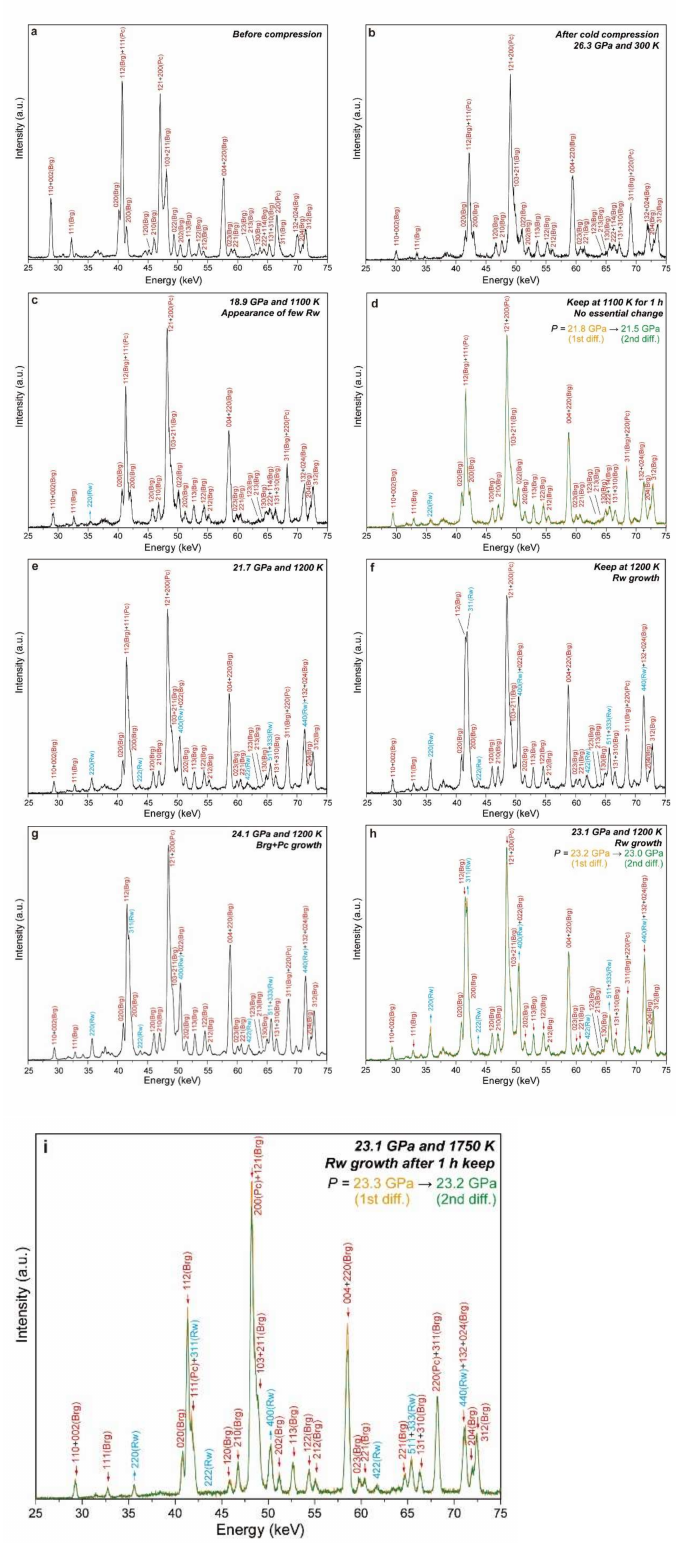
Figure 6. Change in X-ray diffraction patterns of the sample: ( a ) before compression; ( b ) after cold compression; ( c ) after reaching 1100 K; ( d ) maintaining at 1100 K for 1 h; ( e ) after heating to 1200 K; ( f ) after maintaining at 1200 K; ( g ) after increasing pressure to 24.1 GPa at 1200 K; ( h ) during spontaneous pressure decrease from 23.2 to 23.0 GPa at 1200 K; ( i ) during spontaneous pressure decrease from 23.3 to 23.2 GPa at 1750